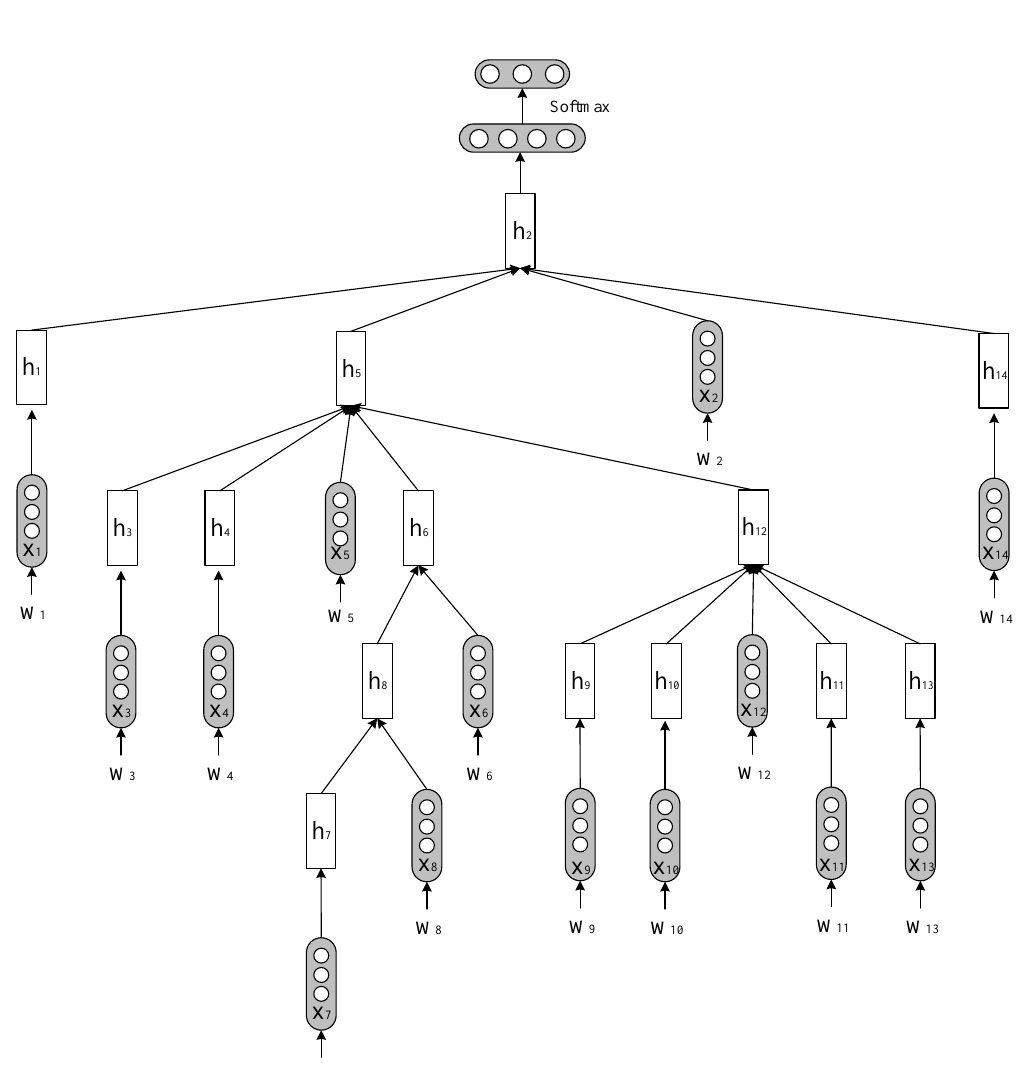
Figure 8. Hashtag recommendation with Tree-LSTM